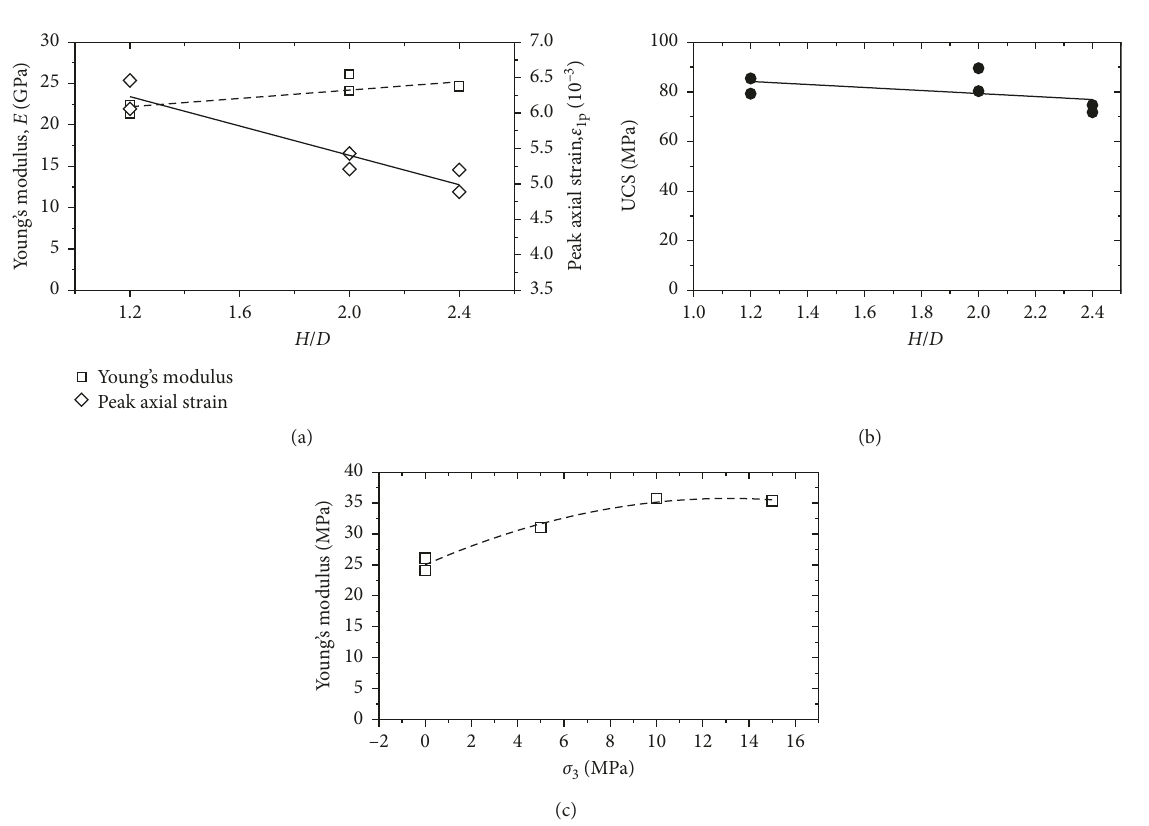
Figure 2: (a) Relationship between Young’s modulus and peak axial strain and the H / D ; (b) relationship between the UCS and the H / D ; (c) relationship between Young’s modulus and the confining pressures.